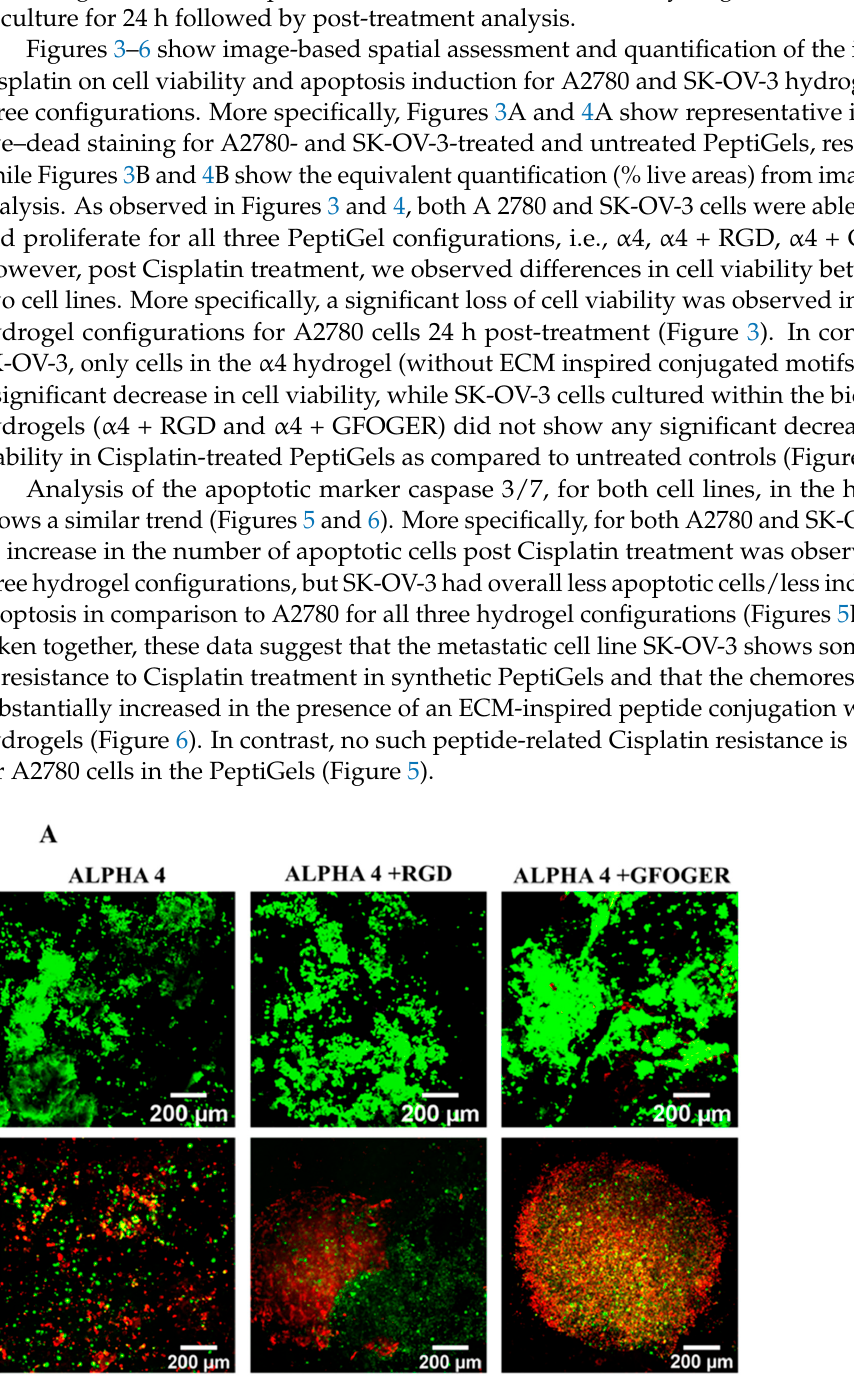
Figure 3 . Effect of the chemotherapeutic Cisplatin on the viability of A2780 EOC cells grown in different synthetic PeptiGels, 24 h post-treatment ( A ): Representative images for live–dead (green– red) staining for both treated and untreated (control) A2780 PeptiGels. ( B ) Image analysis-based quantification of live (green) image areas for A2780 cells grown in the peptides. Scale bar = 200 μ m. Quantitative data represent mean ± SEM for multiple images ( ≥ 3) and multiple hydrogels ( ≥ 3). *** p ≤ 0.001, **** p ≤ 0.0001 .